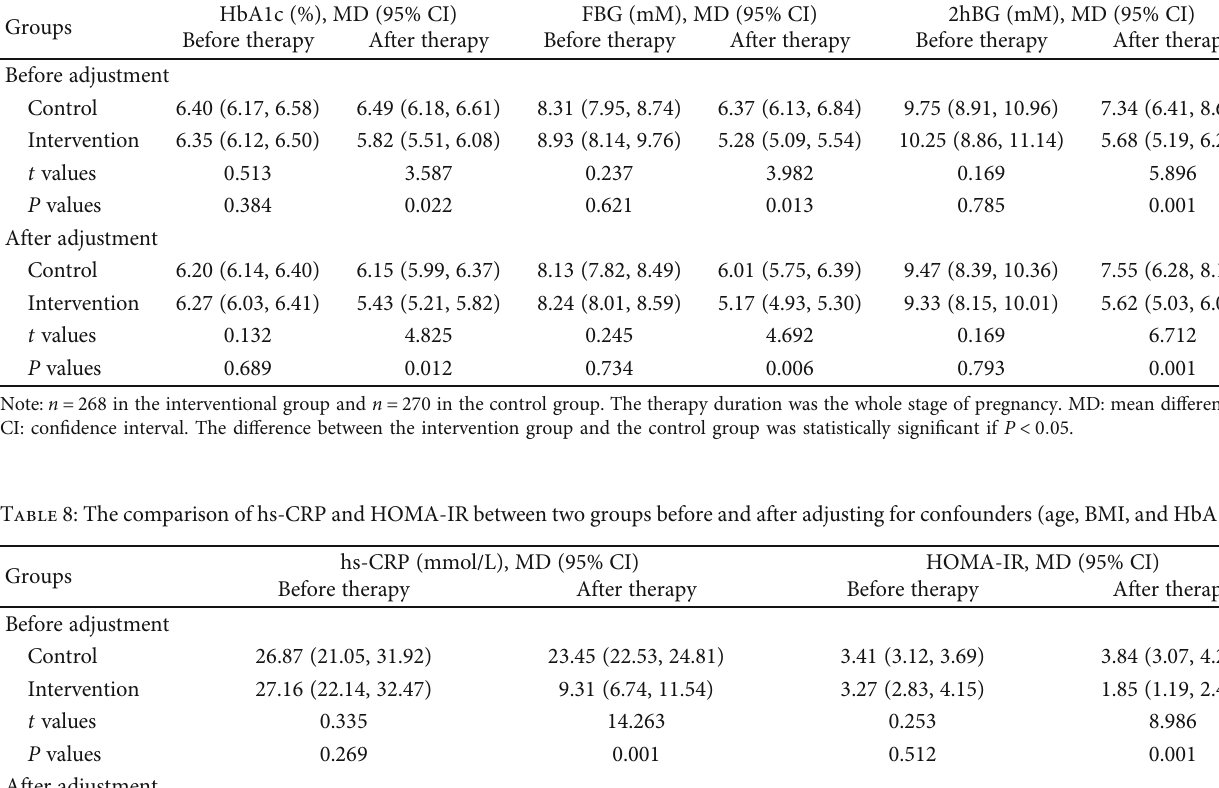
Table 7: The comparison of blood glucose between two groups before and after adjusting for confounders (age, BMI, and HbA1c). Groups